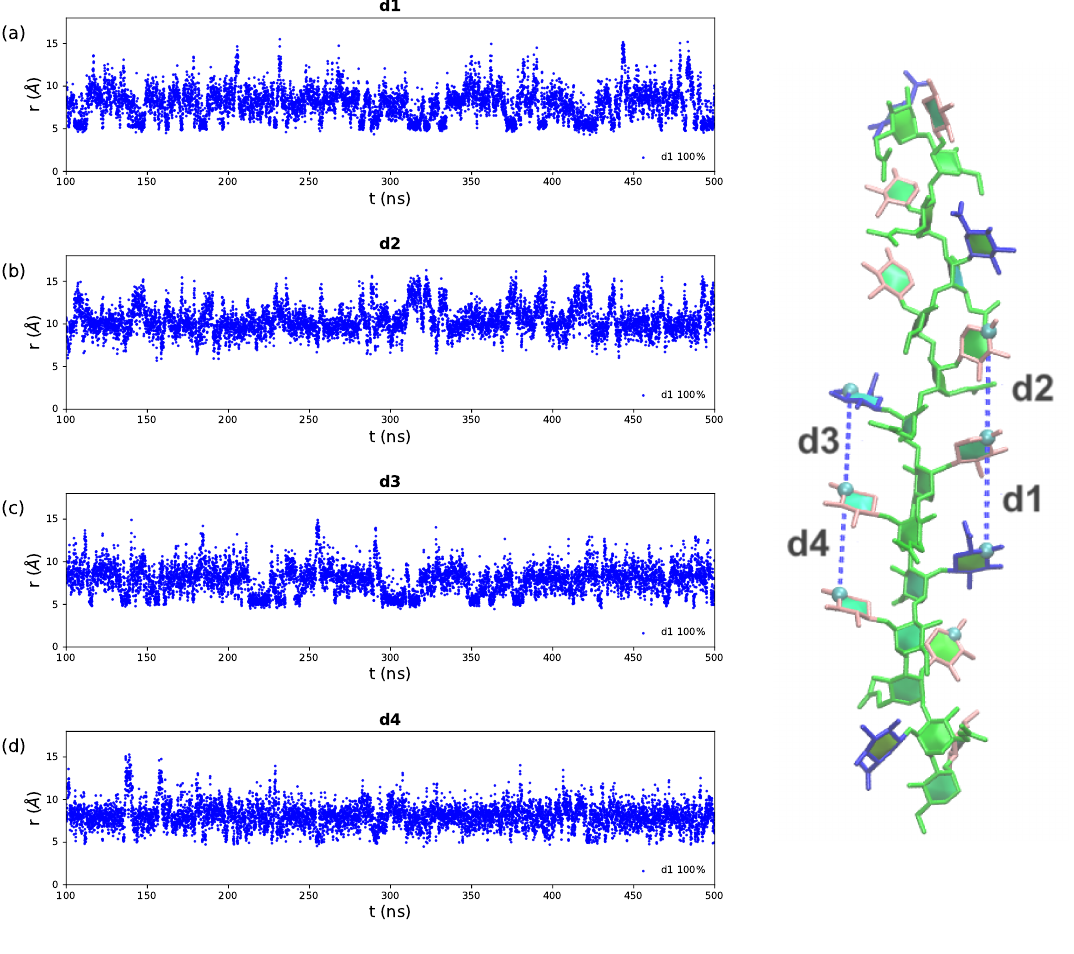
Figure A4. The time series for the distances between interacting side chains in the cnA’ molecule labeled on the right. ( a ) The β DGlcA and β DXyl distance d1, ( b ) the β DXyl and β DXyl distance d2 ( c ) the β DGlcA and β DXyl distance d3 and ( d ) the β DXyl and β DXyl distance d4. Here in each case d is defined to as the distance from C4 in one residue to C4 in the proximal side chain residue. The first 100 ns of simulation are considered equilibration and are not shown. The residues and substitutions are coloured as follows: α DMan—green; β DGlcA—blue; β DXyl—pink and